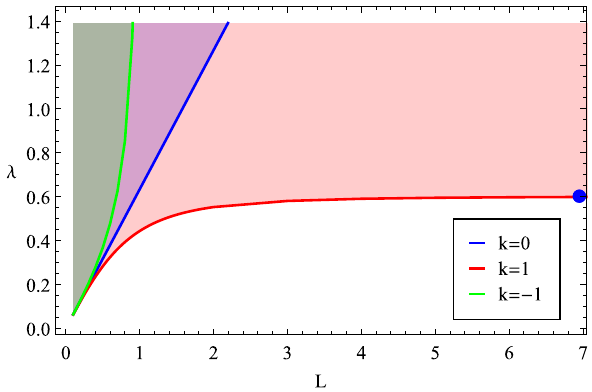
Fig. 9 The threshold curves for AdS black hole with different cur- vatures. The blue dot represents the threshold value of Schwarzschild black